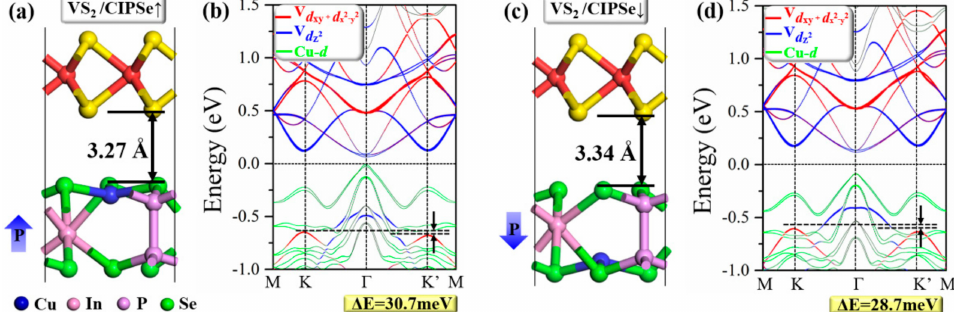
Figure 2. Atomic structures with interlayer distance and calculated band structures with SOC of ( a , b ) 2H–VS 2 /CIPSe ↑ and ( c , d ) 2H–VS 2 /CIPSe ↓ heterostructures. The arrows “ ↑ ” and “ ↓ ” represent ferroelectric upward and downward polarizations. The solid lines in red, blue, and green represent the contributions from V– d xy + d x 2 − y 2 , V– d z 2 and Cu– d orbitals, respectively. The Fermi level is set to